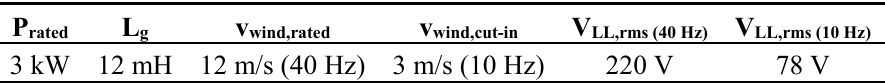
Table 2. PMSG parameters.